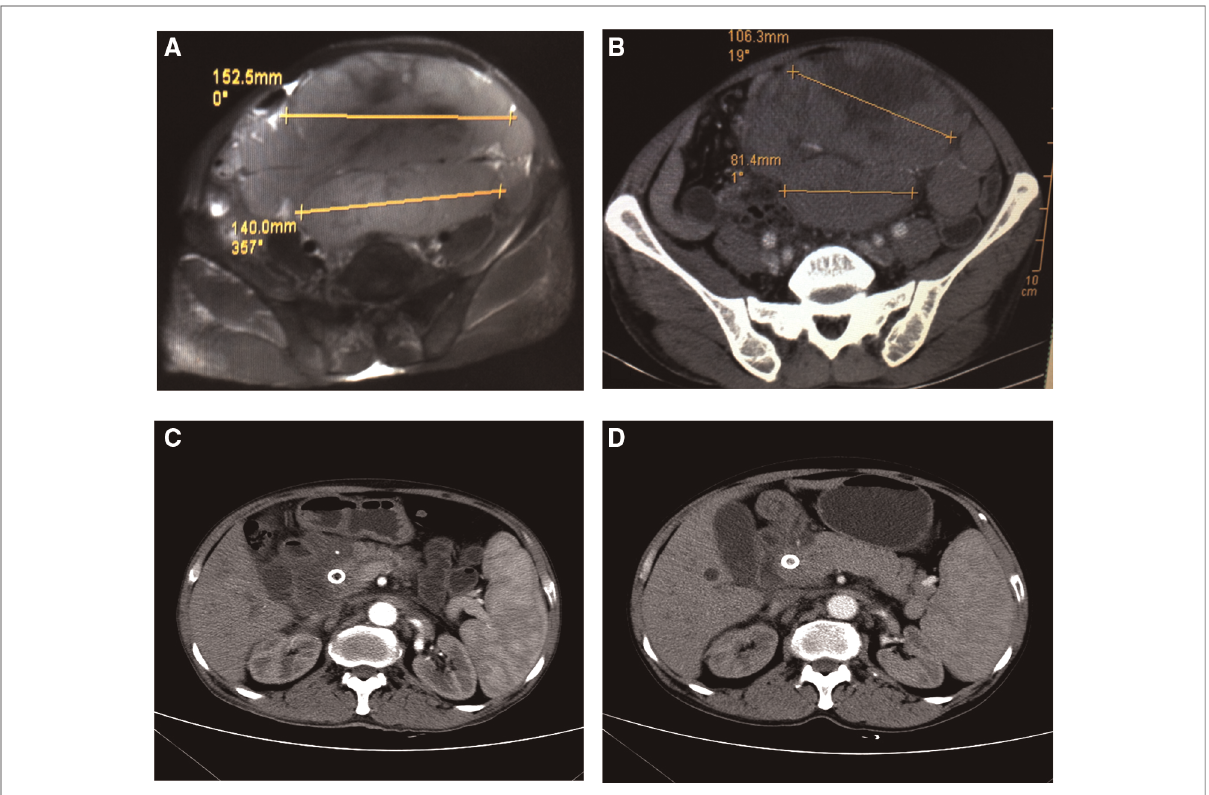
FIGURE 3 Computed tomography (CT) fi ndings before and after endoscopic ultrasonography – guided biliary drainage. ( A ) A CT image obtained shows a large lump in the abdominal cavity. ( B ) An image obtained (one month after EUS-BD) shows signi fi cant shrinking of the abdominal mass. ( C ) CT re- examination (four month after EUS-BD) showed that most of the mass shadows in the abdomen, pelvic cavity, and retroperitoneal cavity were signi fi cantly smaller than previously, the pressure on the abdominal viscera was reduced, and the expansion of the portal vein trunk and left and right branches was lessening, with no apparent change in the common bile duct. ( D ) A review total abdominal CT (one year later) showed that abdominal and retroperitoneal lymph node enlargement, little change in internal and external bile duct dilatation,more absorption of gas in the biliary system than previously, and common bile duct stent